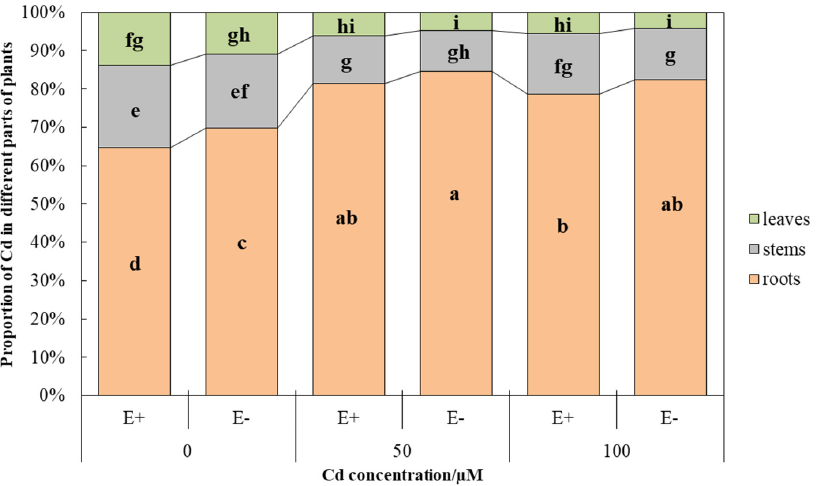
Figure 4. Cd distribution in different parts of Hordeum brevisublatum under different CdCl 2 concentra- tion stress. Lowercase letters (a–i) in the middle of bars indicate significant differences ( p < 0.05) of E+ and E − plants under the different concentrations of CdCl 2 stress. Table 3. Cd concentrations in different parts (leaf, stem, root) and the whole of E+ and E − Wild Barley under stress with different CdCl 2 concentrations, and the transport index from root to stem (TI roots-stems ) and from stem to leaf (TI stems-leaves ).